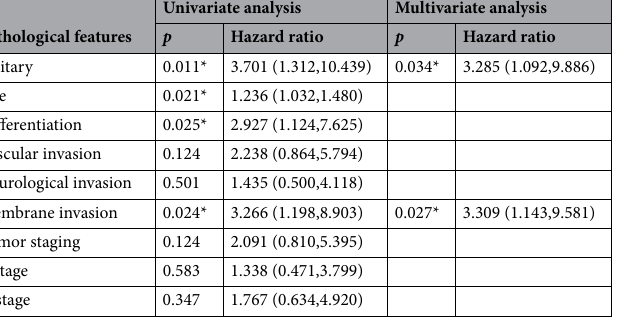
Table 3. Logistic regression analysis for predicting early recurrence of IMCC based on pathological characteristics (Pathological model). * p < 0.05.